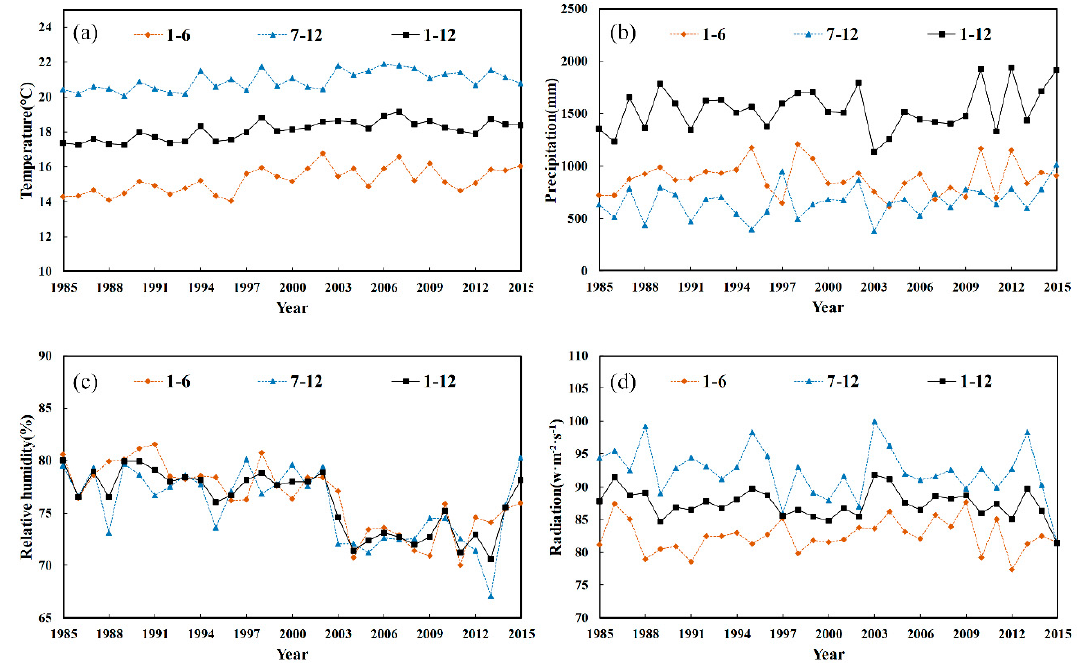
Figure 9. Changes in ( a ) temperature, ( b ) precipitation, ( c ) relative humidity, and ( d ) radiation data in Zhejiang Province from 1985 to 2015.